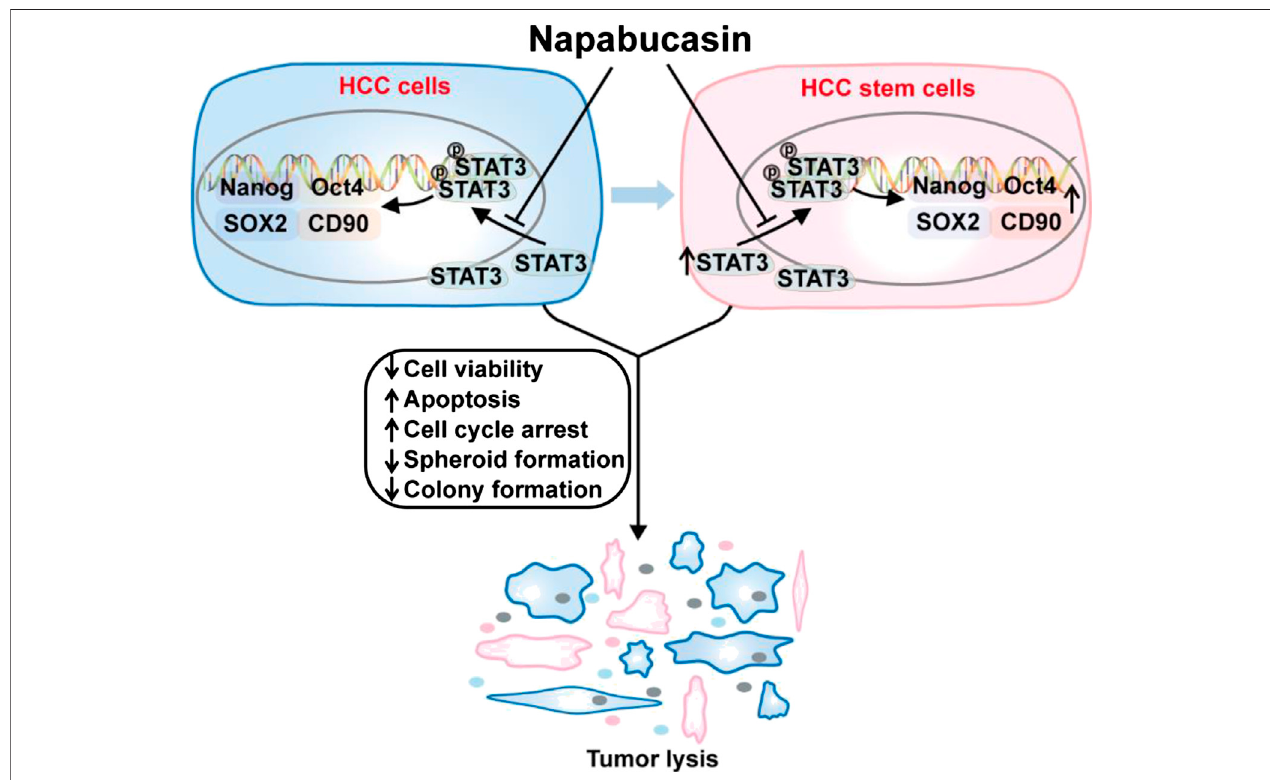
FIGURE 8 | Napabucasin reduces cancer stem cell characteristics in hepatocellular carcinoma. Napabucasin signi fi cantly decreased the viability of HCC cells in vitro byinducingapoptosis and cellcycle arrest. Inaddition, itsuppressedCSC-relatedgeneexpression and spheroidformation invitro ,indicatingdepletionofCSCs. Further, napabucasin also restricted HBV replication in HBV + HCC